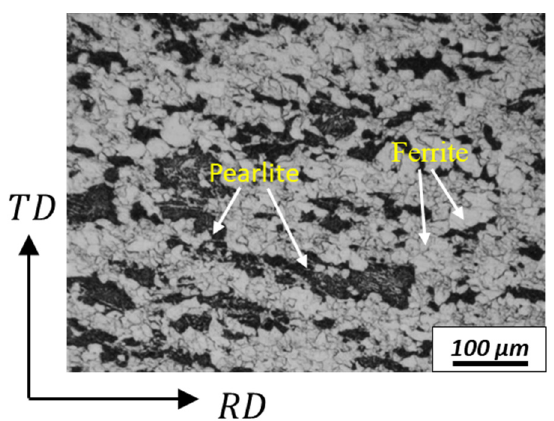
Figure 3. The microstructure of the as-received high-strength EH47 hull steel.